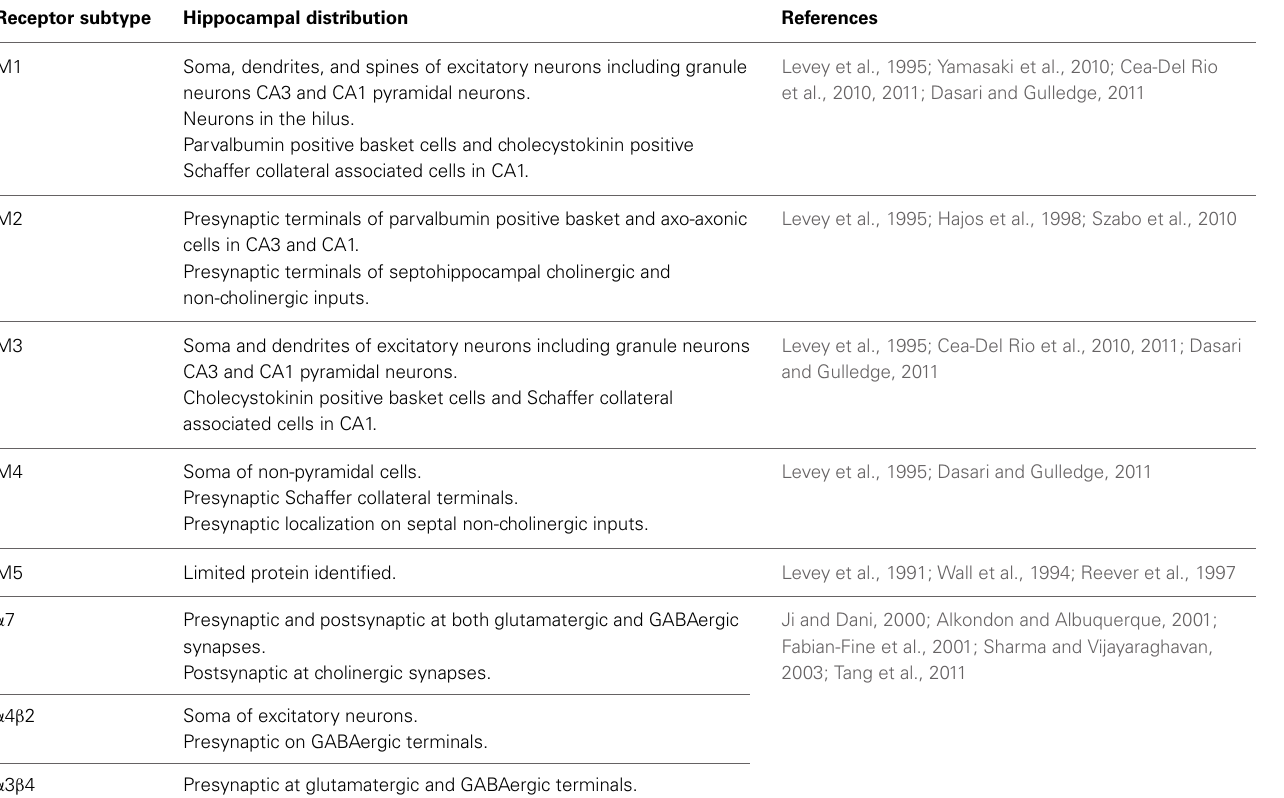
Table 1 | Distribution of acetylcholine receptors in the hippocampus. Receptor